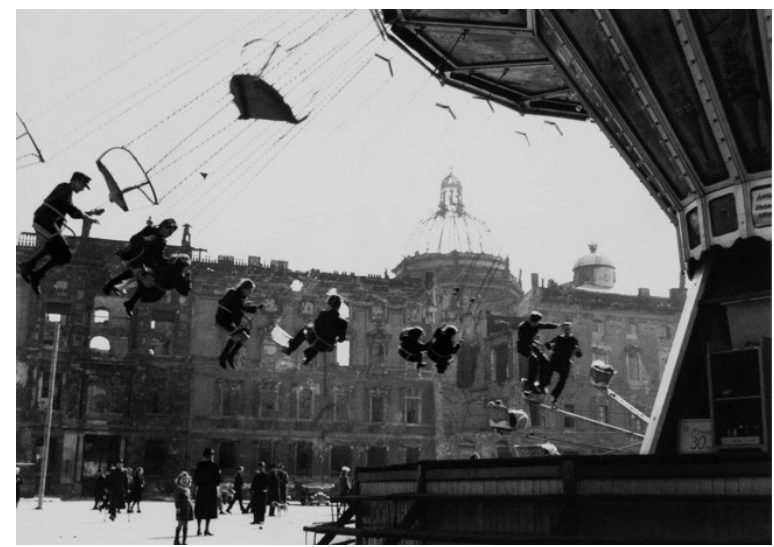
Figure 8. Henry Ries. Karussellfahrt im Lustgarten vor dem zerbombten Berliner Schloss in Mitte ( Carousel Ride in the Pleasure Garden in Front of the Bombed out Berlin Castle ). 1946. Photograph. © Henry Ries. Deutsches Historisches Museum. Invoice No. 2007 / 4176.108, file PH009425.